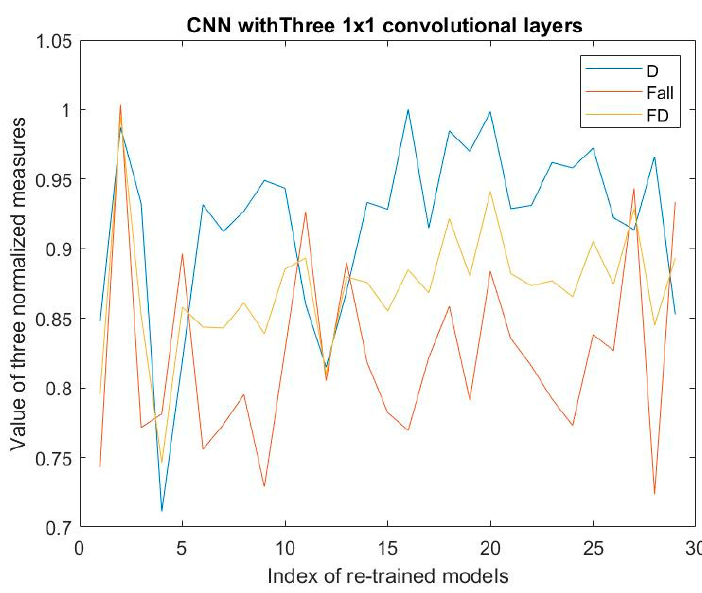
Figure 7. Results regarding only 1 × 1 convolutions’ CNN.